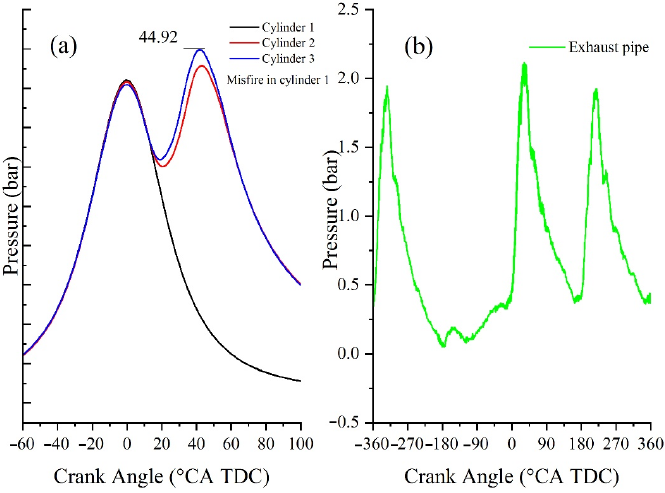
Figure 14. The exhaust pressure and in-cylinder pressure curves without knocking: ( a ) the pressure in the exhaust pipe; ( b ) the pressure in cylinders.